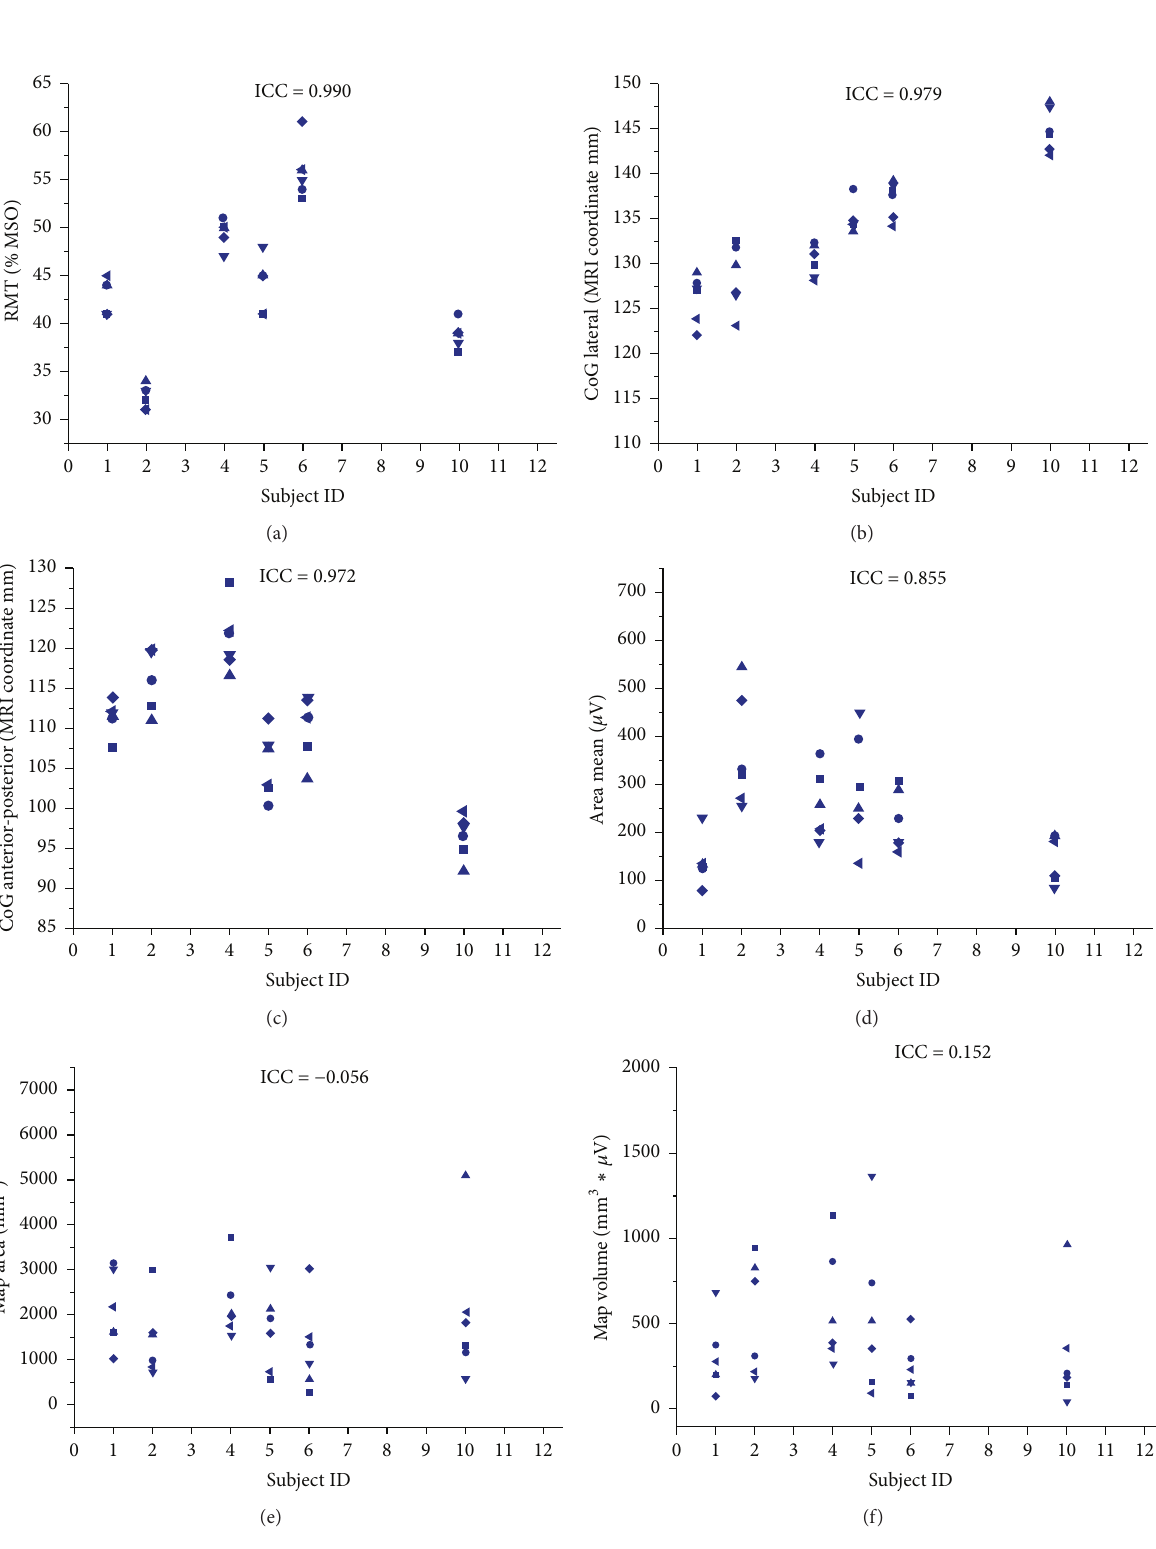
Figure 2: Intrasubject distribution of original data for six experimental sessions ( ◼ : Session 1; e : Session 2; 󳵳 : Session 3; 󳶃 : Session 4; X : Session 5; 󳶣 : Session 6) in the left, dominant hemisphere of six subjects for RMT (a), medial-lateral CoG (b), anterior-posterior CoG (c), mean map MEP amplitude (d), map area (e), and map volume